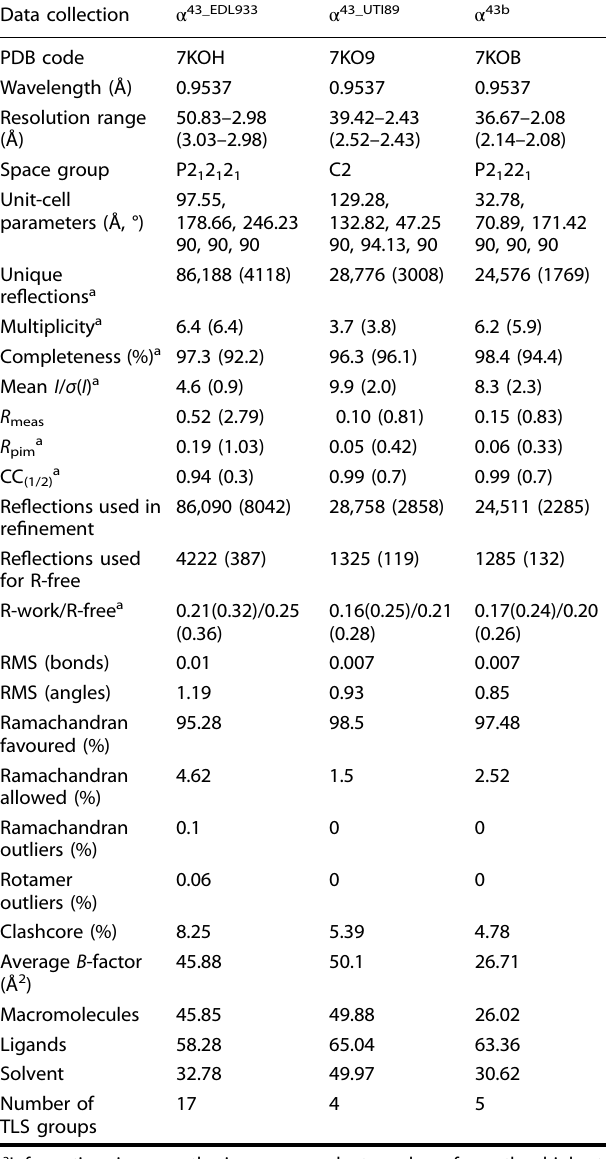
a Information in parenthesis corresponds to values from the highest resolution